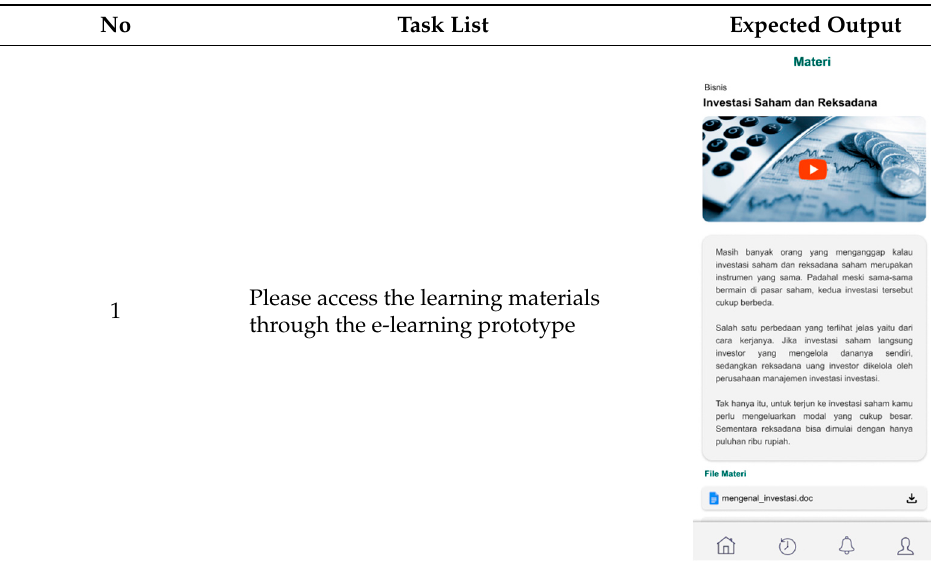
Table A3. List of